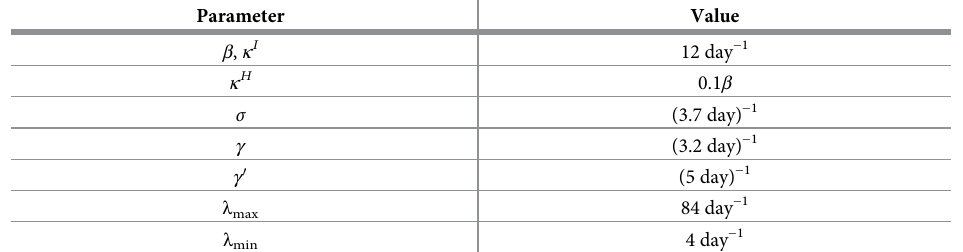
Table 3. Mean transmission and transition rates and maximum/minimum contact rates for the surrogate-world simulations with the stochastic SEIHRD model (S1 Fig). The mean rates are taken to be the same for all nodes; hence, the nodal indices are suppressed. The latent period σ − 1 and duration of infectiousness in the community γ − 1 are approximated from those in refs. [10] and [12]; the duration of hospitalization γ 0 − 1 is from ref. [68], and the transmis- sion rate β is fit to be consistent with data for respiratory viruses [48] and to roughly reproduce NYC